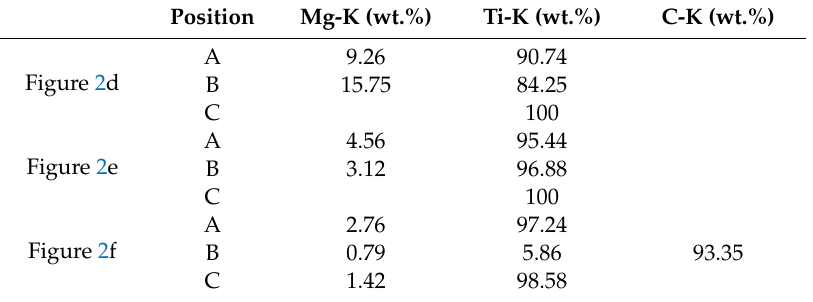
Figure 2. The SEM morphology and EDS analysis results of composites with different CNT contents ( a , d ) 0%; ( b , e ) 0.5%; and ( c , f ) 1.0%. Table 1. Energy spectrum analysis of the composite